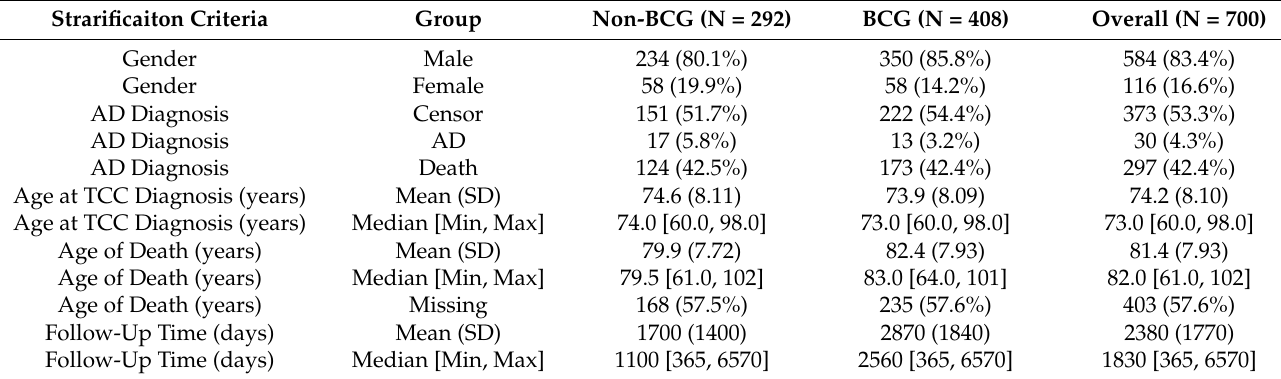
Table 2. Characteristics of patients in the HUH population.